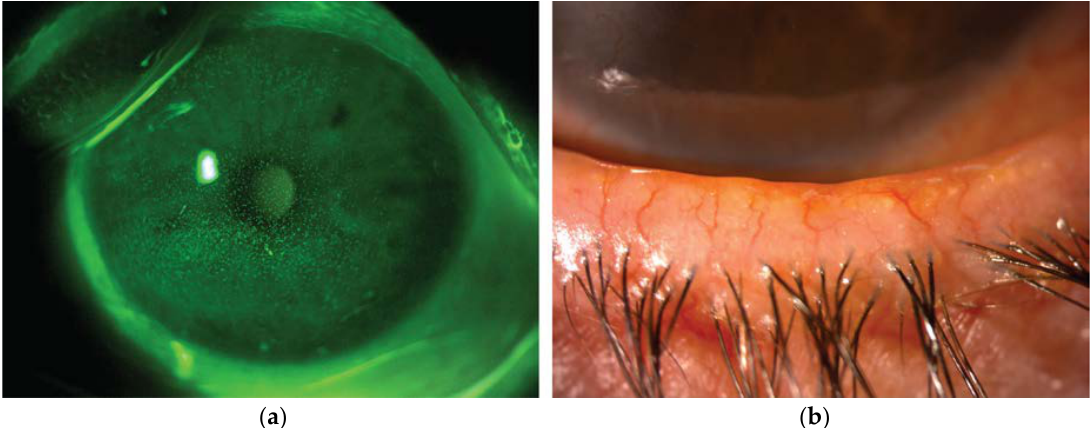
Figure 1. Representative image from a patient with dry eye disease owing to Meibomian gland dysfunction. ( a ) Slit lamp photograph of the cornea after instillation of 20 µL unpreserved 2% sodium fluorescein (corneal fluorescein staining). The epithelial damage is visible as multiple punctate epithelial erosions staining with fluorescein scattered over the corneal surface. ( b ) Slit lamp photograph of the lid margin showing typical signs of meibomian gland dysfunction, including hyperemia and irregularity of the lid margin, telangectasia, plugged gland orifices and anterior displacement of the mucocutaneous junction. Hyposecretion of meibomian lipids leads to tear film instability and increased evaporation rate.